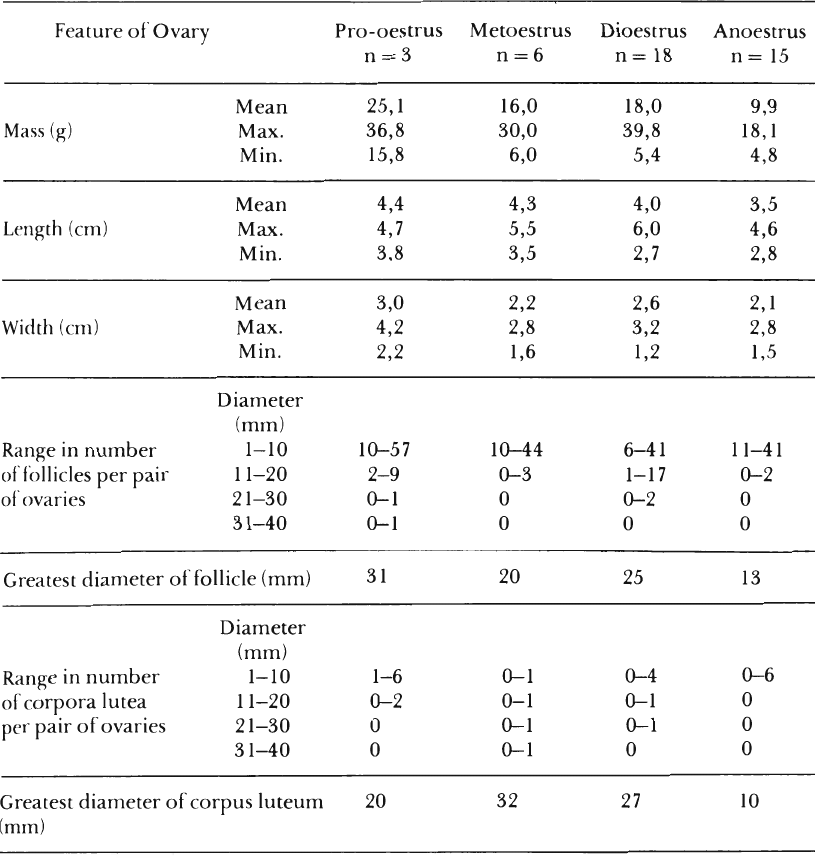
Characteristics of the ovaries of 42 adult, non-pregnant Burchell's zebra mares shot in the Central District ojthe Kruger National Park